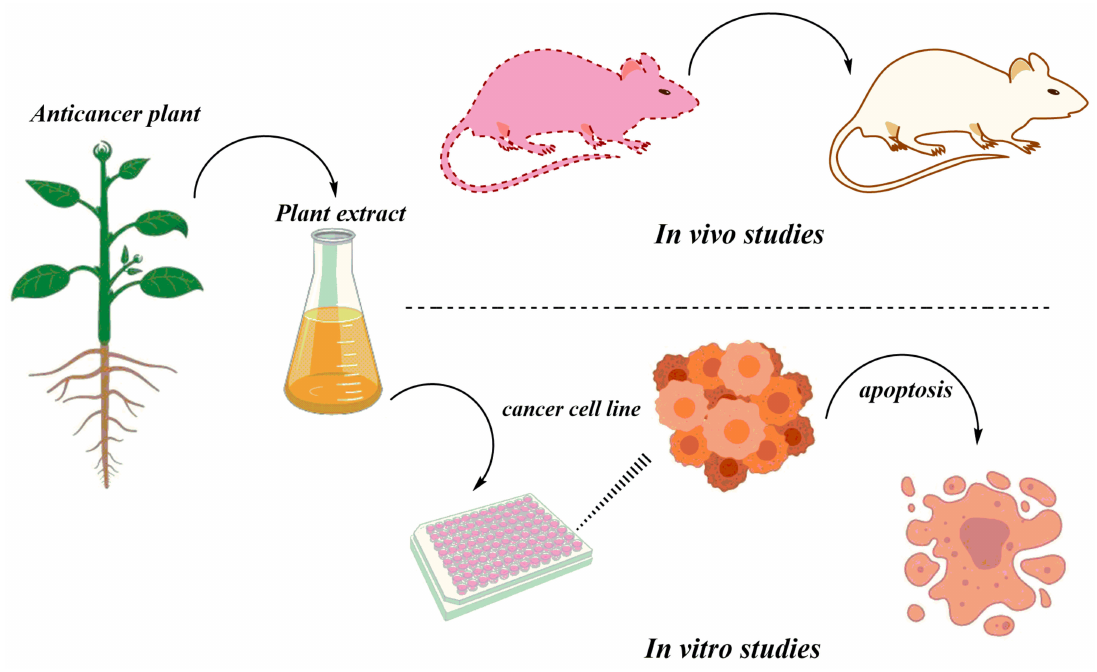
Figure 3. A depiction of general strategies applied for assaying extracts / phytochemicals from important medicinal plants for their anticancer activity both in vitro and in